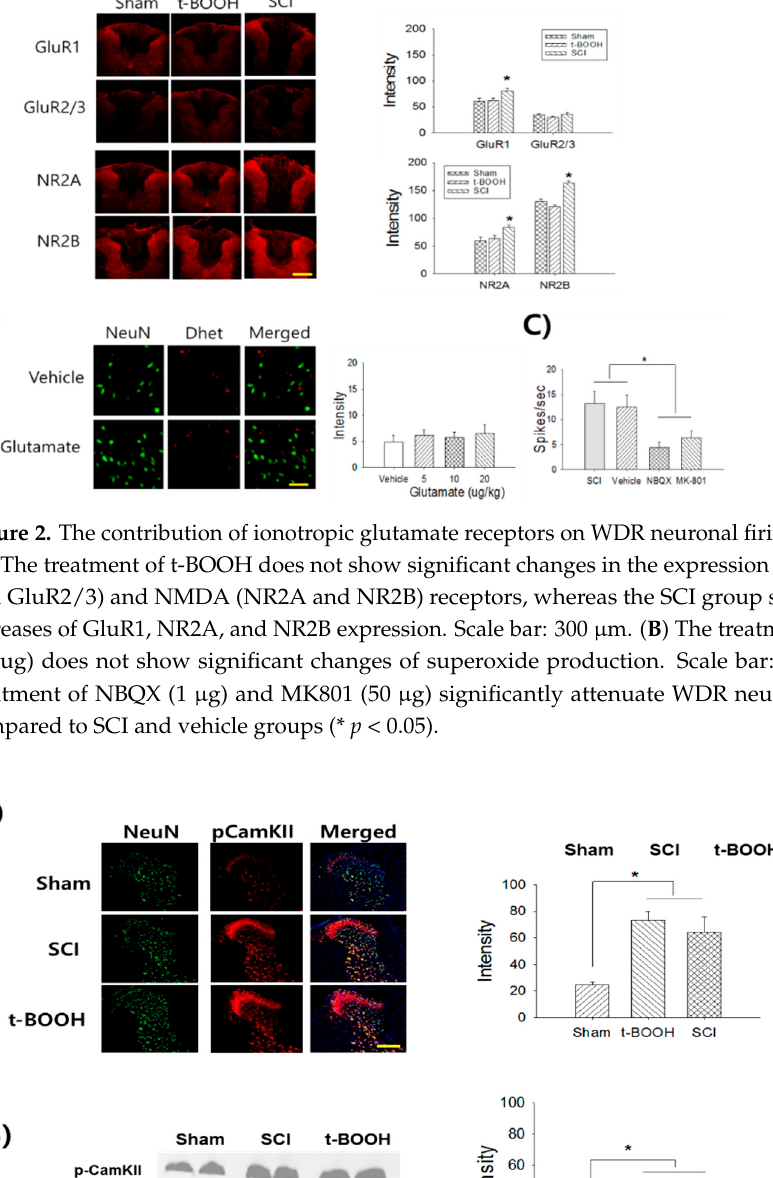
Figure 3. Superoxide-mediated activation of CamKII in the thoracic dorsal horn neurons. ( A ) The double immunofluorescence staining shows expression of pCamKII among the sham, SCI, and t-BOOH groups, respectively. The treatments of t-BOOH and SCI show an increase of pCamKII expression in the T7/8 thoracic dorsal horn neurons compared to the sham control group (* p < 0.05). ( B ) In Western Blot, t-BOOH and SCI groups show significant increases of pCamKII expression compared to the sham group. Scale bar: 300 μ m.